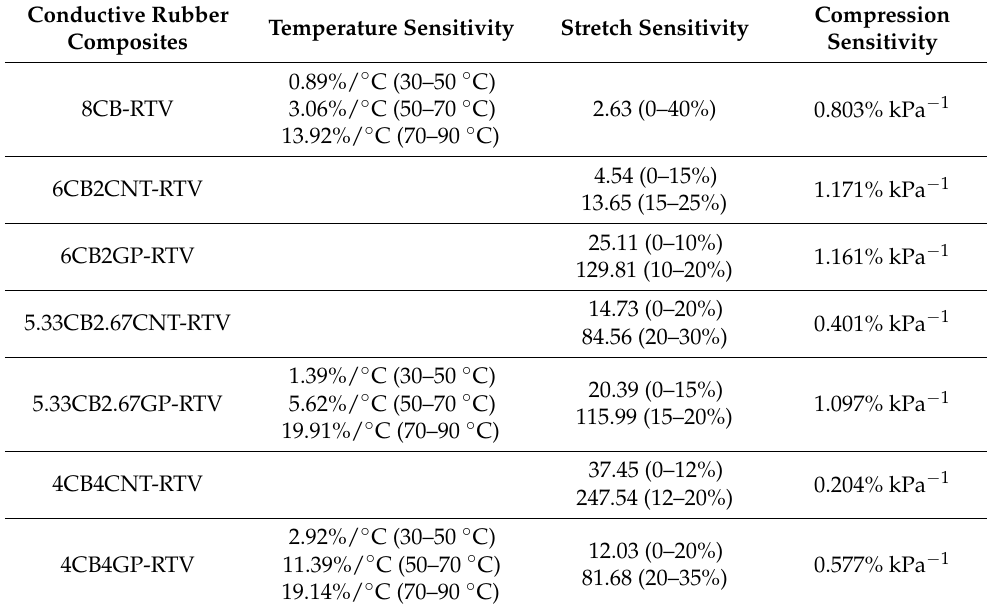
Table 1. Sensitivities of conductive rubber composites with different material